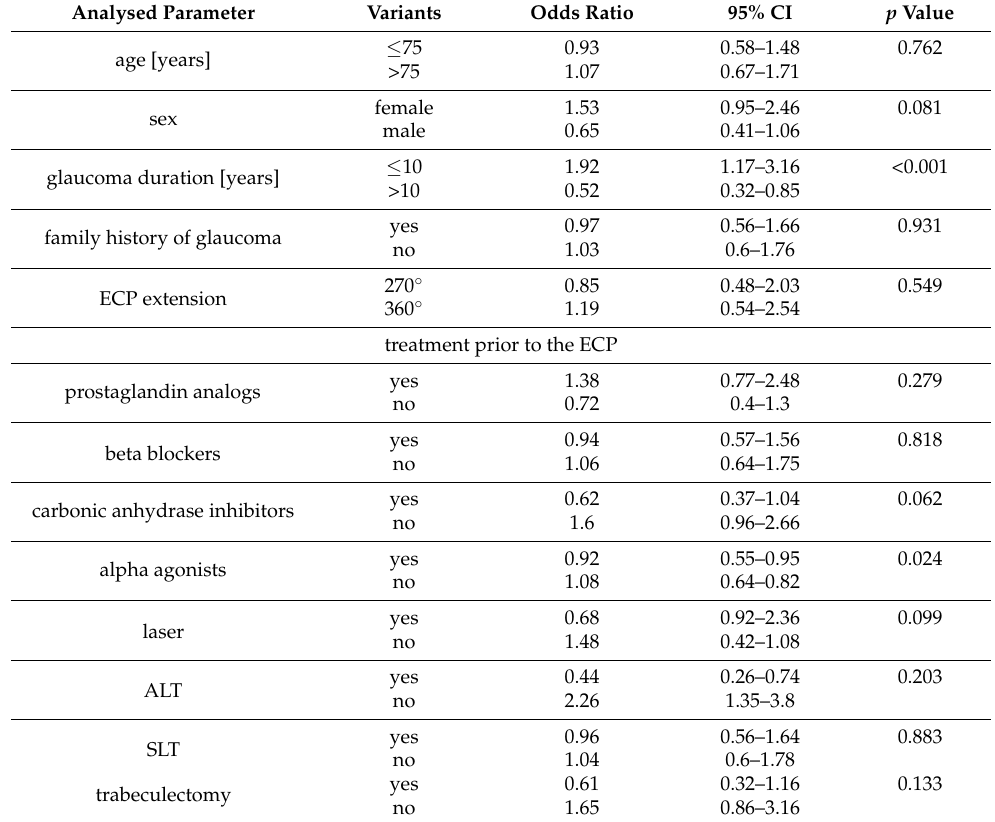
Table 3. Evaluation of the selected parameters influencing the therapeutical success of endoscopic cyclophotocoagulation by the univariate logistic regression method.